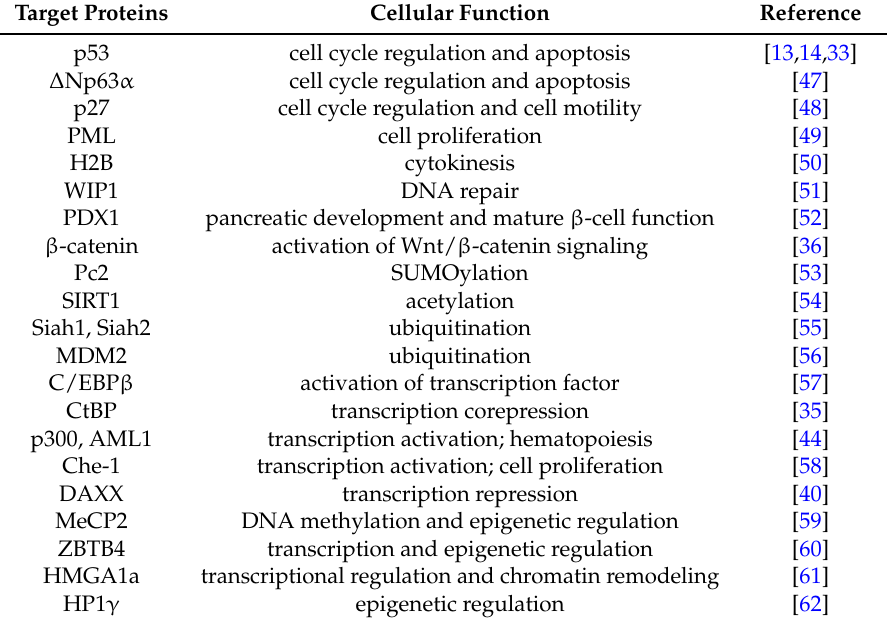
Table 1. Phosphorylation targets of Homeodomain-Interacting Protein Kinase 2 (HIPK2) and functional